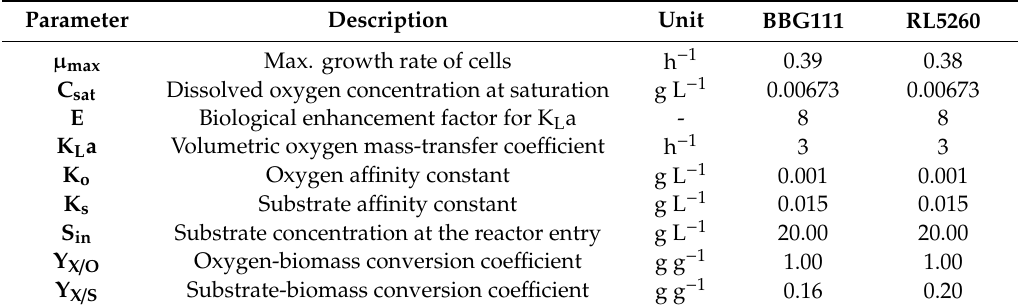
Table 4. General model parameters and their corresponding values used for B. subtilis BBG111 ( sfp +